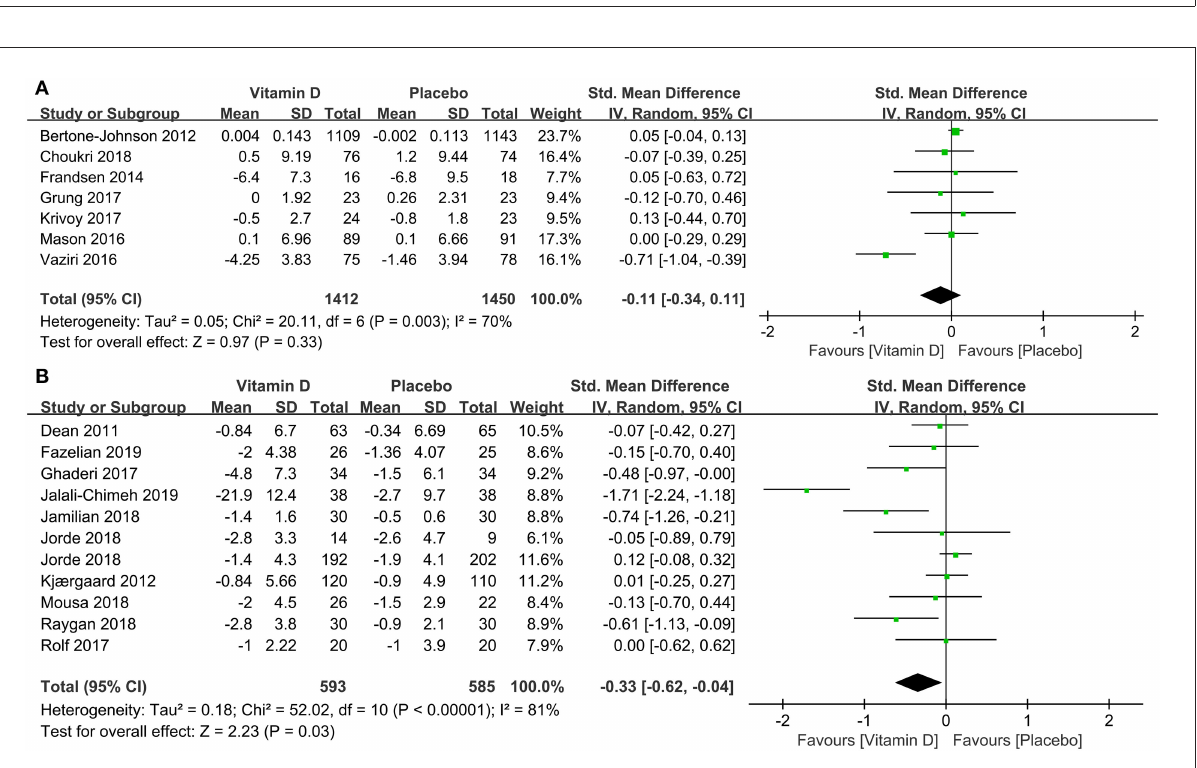
FIGURE4 Forest plot of the correlation between supplementary doses of vitamin D and the incidence of depression. (A) low doses ( ≤ 2,800 IU/day); (B) high doses ( > 2,800 IU/day).